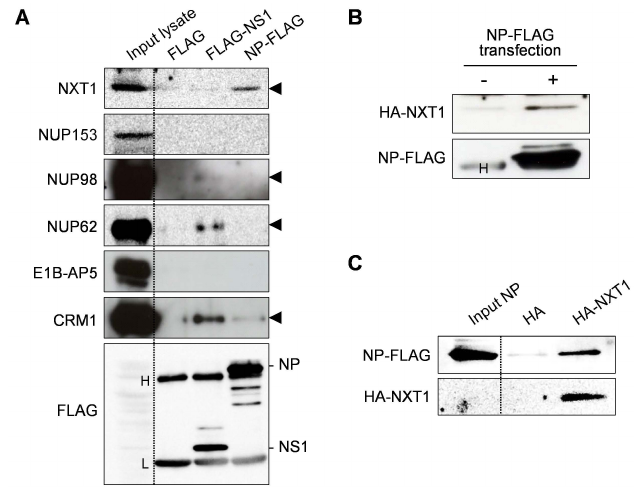
Figure 1. Identification of nuclear transport factor 2 (NTF2)-like export protein 1 (NXT1) as a binding partner of influenza nucleoprotein (NP). ( A ) NP-FLAG or FLAG- non-structural 1 (NS1) protein was immobilized on anti-FLAG agarose beads and co-incubated with HeLa whole cell lysate overnight at 4 ˝ C. The beads were collected, washed, and subjected to western blot (WB) analysis with anti-NXT1, anti-NUP153, anti-NUP98, anti-NUP62, anti-E1B-AP5, anti-CRM1, or anti-FLAG antibodies. Data shown are the results of one representative experiment from two independent trials. Black arrowheads indicate specific binding. H and L indicate the heavy and light chains of the agarose-conjugated anti-FLAG antibody; ( B ) Human embryonic kidney (HEK293T) cells were transfected with NP-FLAG/pCAGGS and HA-NXT1/pCAGGS plasmids for 48 h, lysed, and incubated with anti-FLAG agarose beads overnight at 4 ˝ C. The agarose beads were collected, washed, and subjected to WB analysis with anti- hemagglutinin (HA) and anti-FLAG antibodies. Data shown are the results of one representative experiment from two independent trials; ( C ) HA-NXT1 protein was immobilized on anti-HA agarose beads and co-incubated with purified NP-FLAG protein overnight at 4 ˝ C. The beads were collected, washed, and subjected to WB analysis with anti-FLAG and anti-HA antibodies. Data shown are the results of one representative experiment from three independent